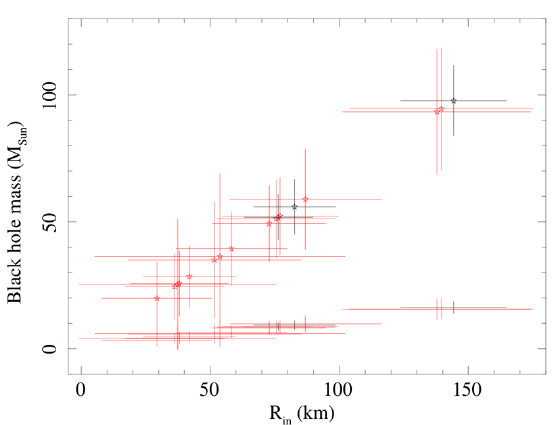
Figure 6. Radius-black hole mass plot, black for 2014 data and red for 2015 data. Star symbol for maximally rotating black